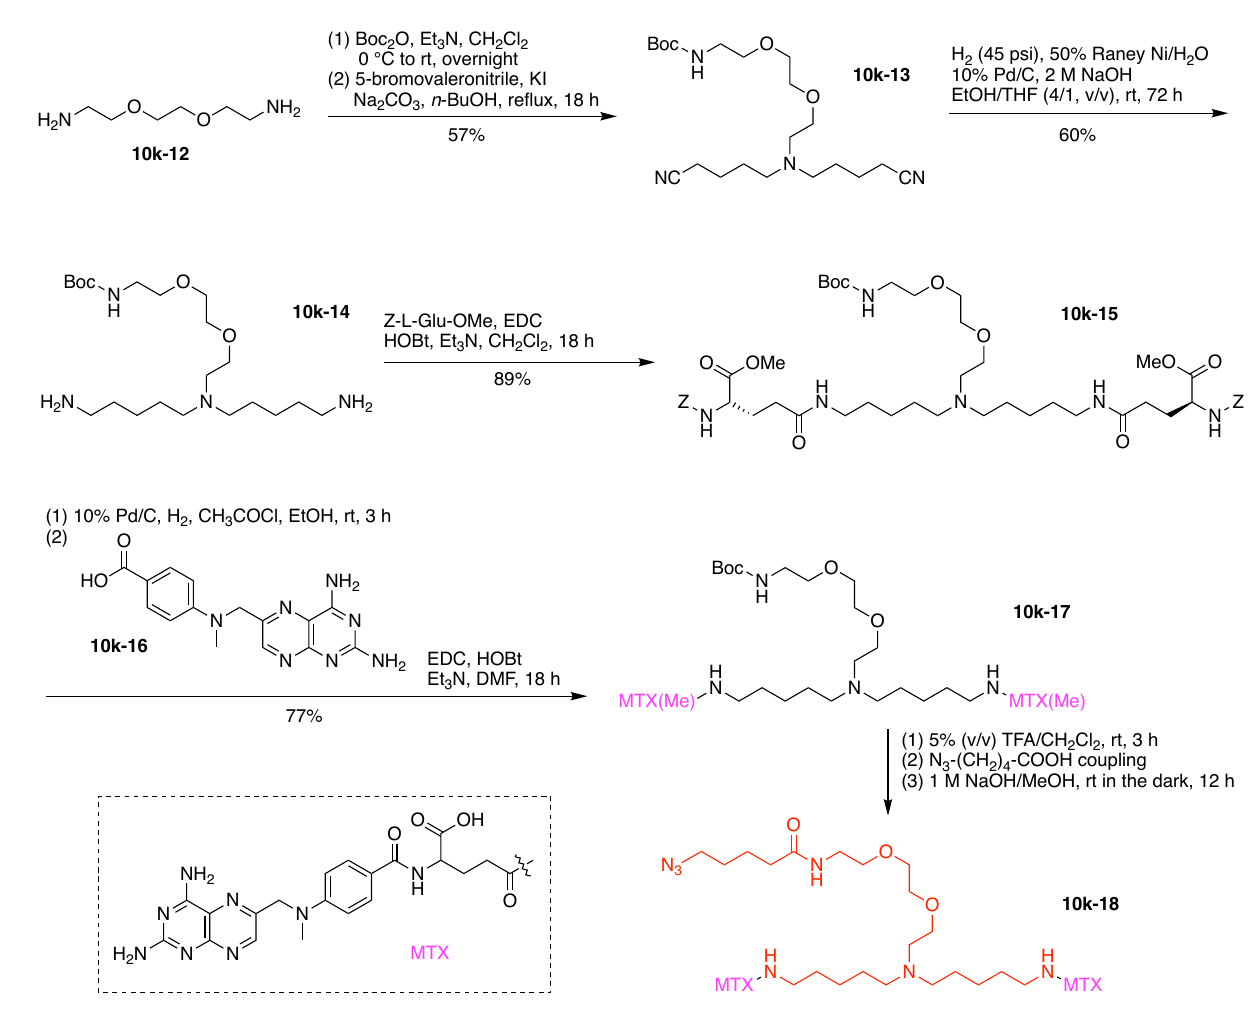
Figure 51. Synthesis of a bis(MTX) construct bearing a single azide.